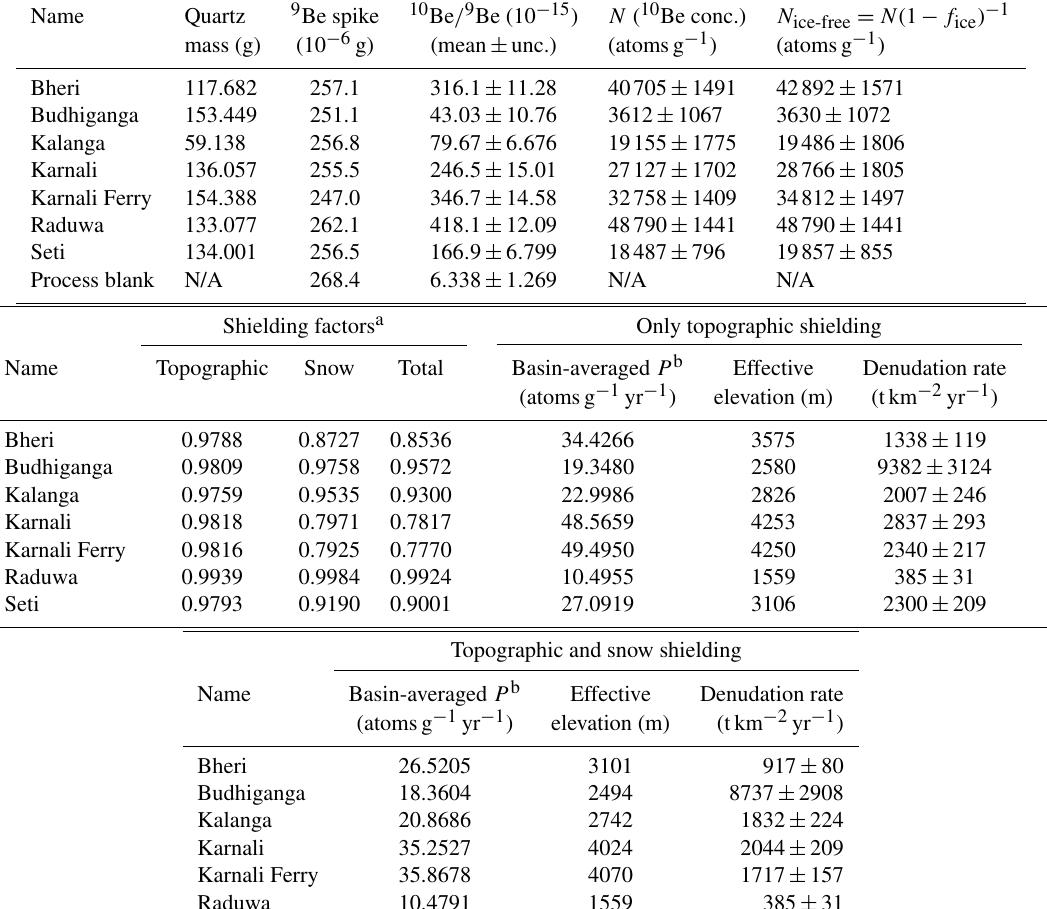
Table 2. Cosmogenic 10 Be concentrations and inferred denudation rates computed first under only topographic shielding and second under the combination of topographic and seasonal snow